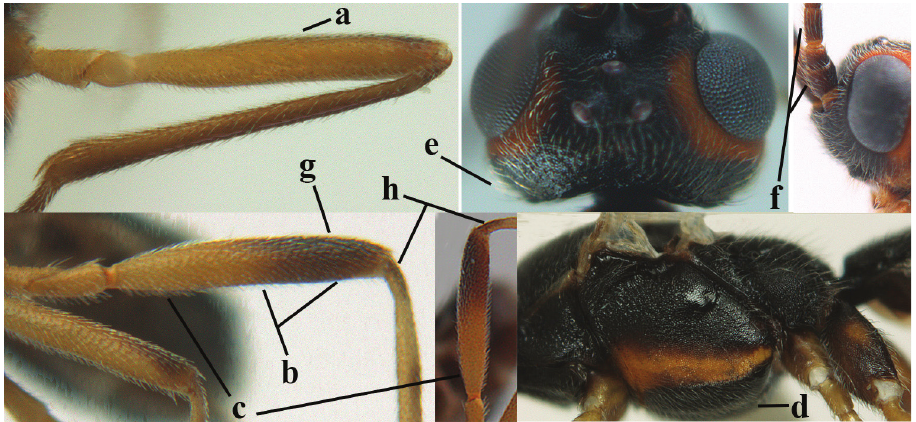
26 Length of fore femur 6.4–8.0 × its maximum width (a) and hind femur (centrally and subapically) parallel-sided (b); hind femur slender basally (c); mesosternum usually black(ish) (d); temple normal (e); scapus ventrally and usually basal half of antenna (dark) brown (f), rarely yellowish; hind femur basally largely yellowish and slightly infuscate subapically (g), paler than ven- tral side of scapus; if hind femur is distinctly infuscate then often also extreme base of hind tibia infuscate (h); [face usually black or dark brown medially and near eyes yellowish brown, but sometimes completely black or rarely completely yellowish; antennal segments of ♂ 35–40(–41), usually 36–38, less than of ♀ , which has usually 37–39 segments] ....... A. leptofemur sp.